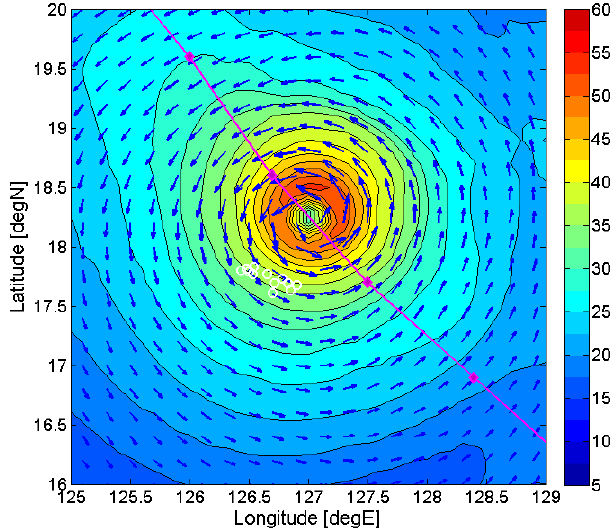
Figure 4. The wind speed [ms − 1 ] and wind direction (blue arrows) on 26 September 2008. The best track position of typhoon Jangmi is plotted as the magenta line with diamonds denoting the 12 position of the storm center. The white circles indicate the daily Argo float locations between 18 September and 29 September 2008.